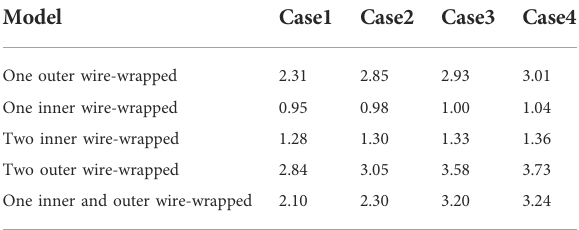
TABLE 2 Number of grids in different models (unit: million).